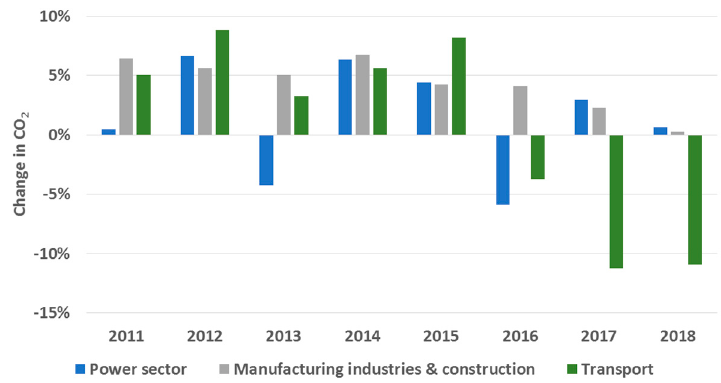
Figure A1. Total CO 2 emissions for Saudi Arabia and annual percentage change (2010-2018). Source: [56].